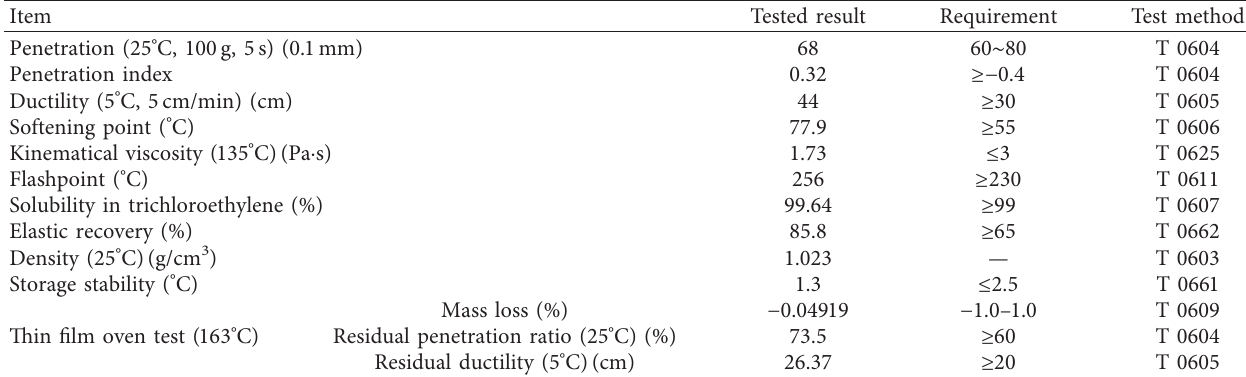
Figure 1: Technical route of this research. Table 1: Properties of SBS